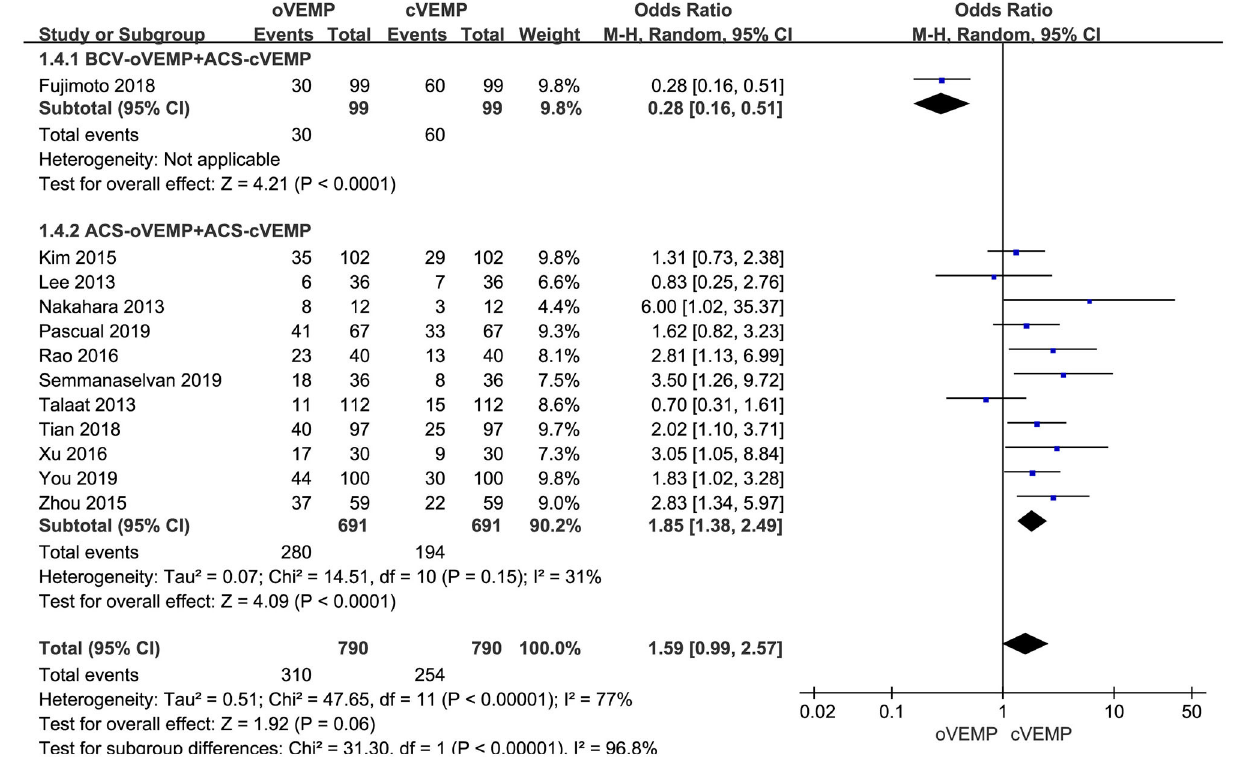
mode, and diagnostic criteria for abnormal VEMP among